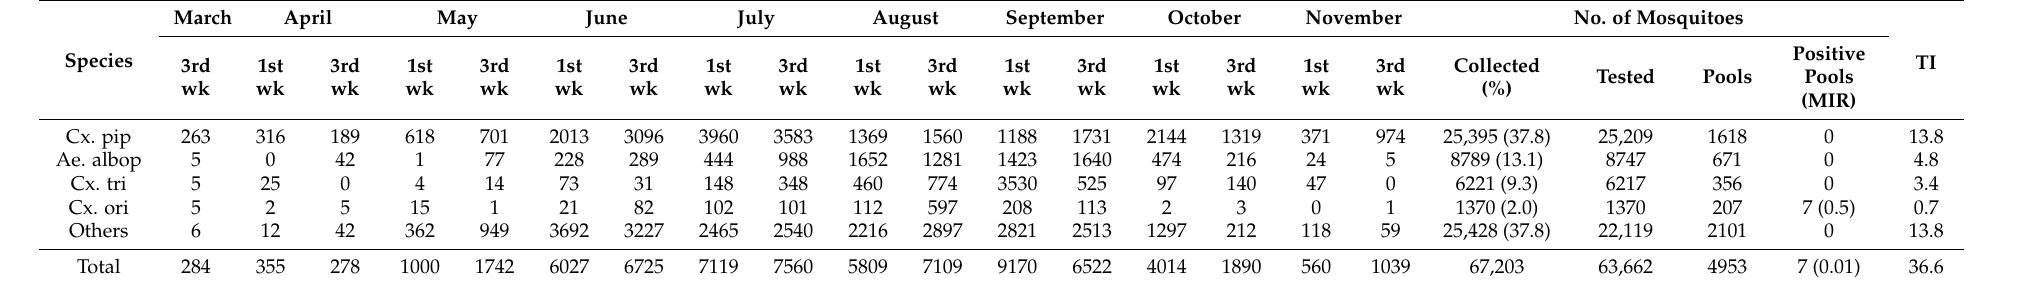
Table 2. Temporal flavivirus distribution and infection by mosquitoes in the Republic of Korea in